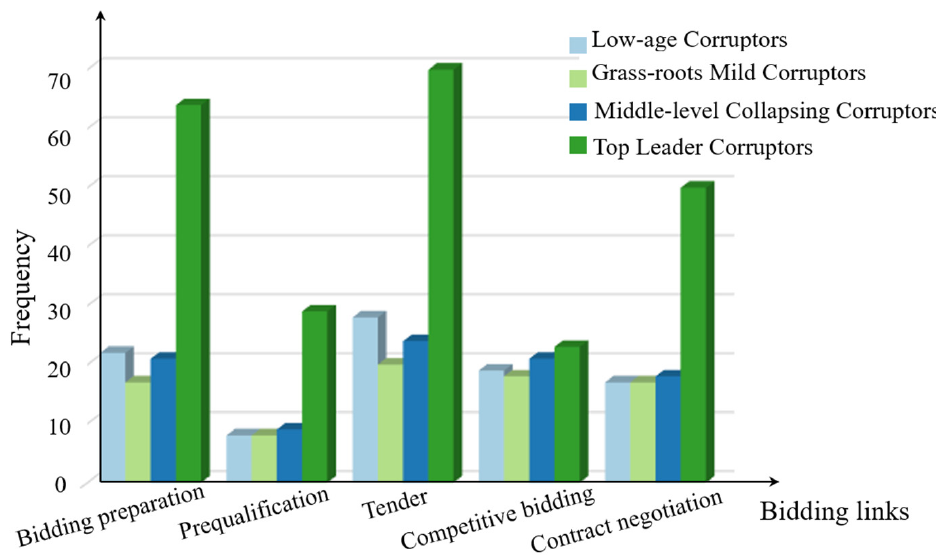
Figure 6. Comparison chart of preference of corruption links.